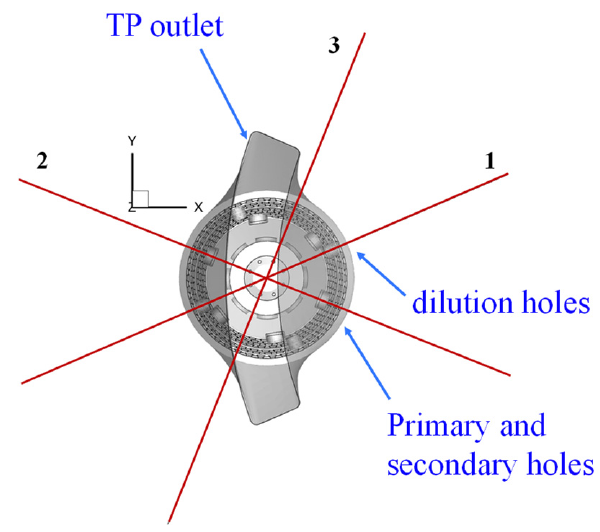
Figure 11. Detail of the section slices for contour visualization. Slice 1 is defined in correspondence to the dilution holes axis. Slice 2 is in phase with the primary and secondary holes. Slice 3 is perpendicular to slice 2 and does not intersect any hole.